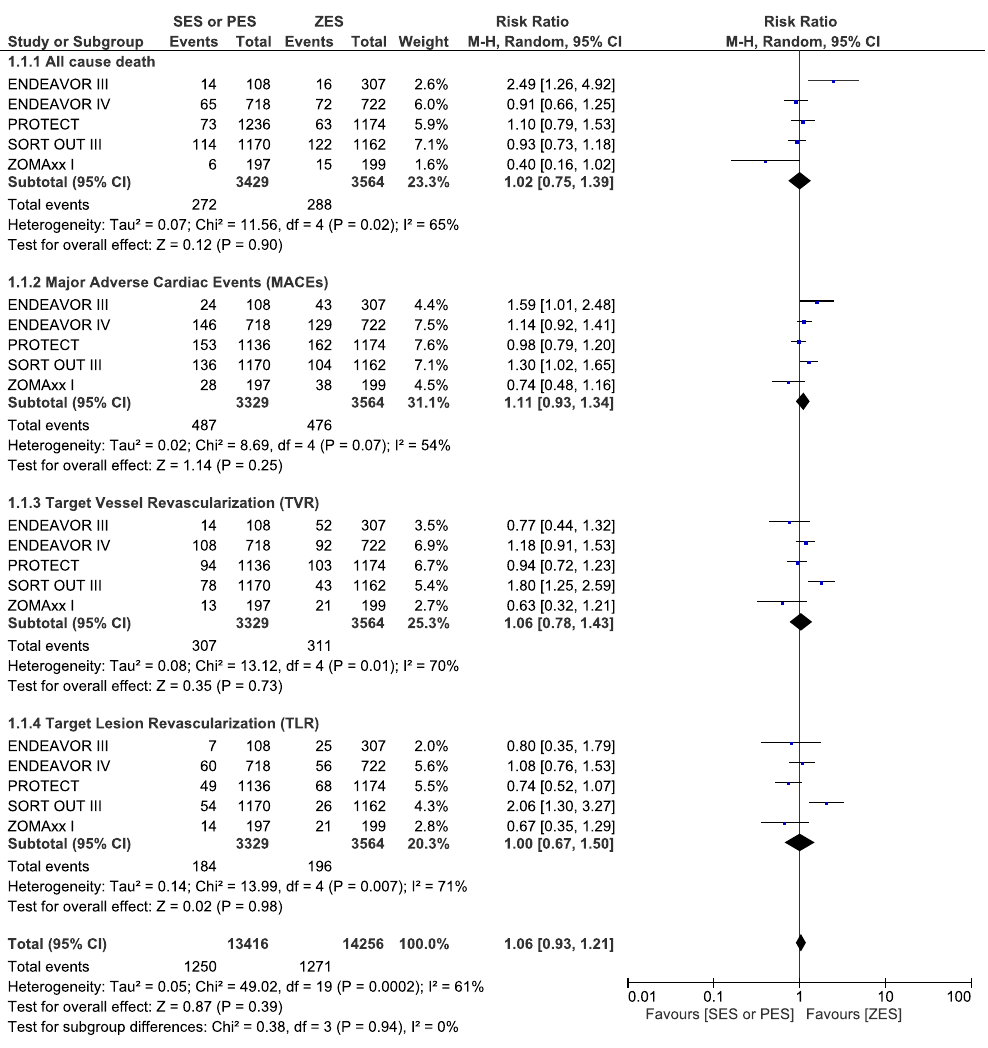
Figure 12. Adverse clinical outcomes which were associated with ZES versus SES or PES at 4–5 years follow-up (part